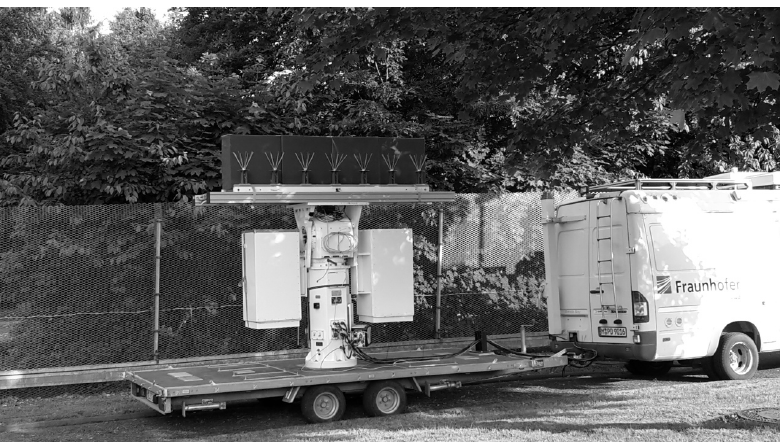
Figure 7. Picture of the bus with the trailer as the carrier platform. The uniform linear array is mounted on top of the white pedestal and steered along-track in the right-looking condition. The Radiation Absorbing Material (RAM) shielding the antennas to one side can be seen on top of the pedestal behind the antenna array.